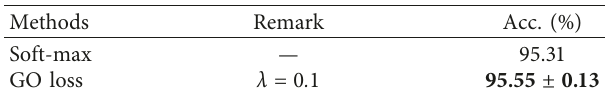
Table 6: Classification accuracy with DenseNet-BC on CIFAR-10 dataset.